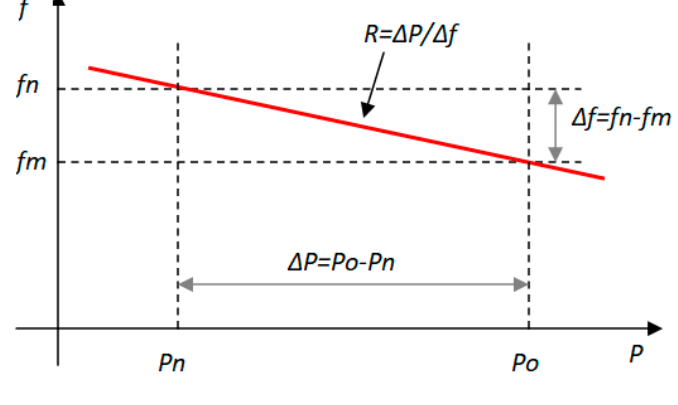
Figure 5. EPS frequency droop control.